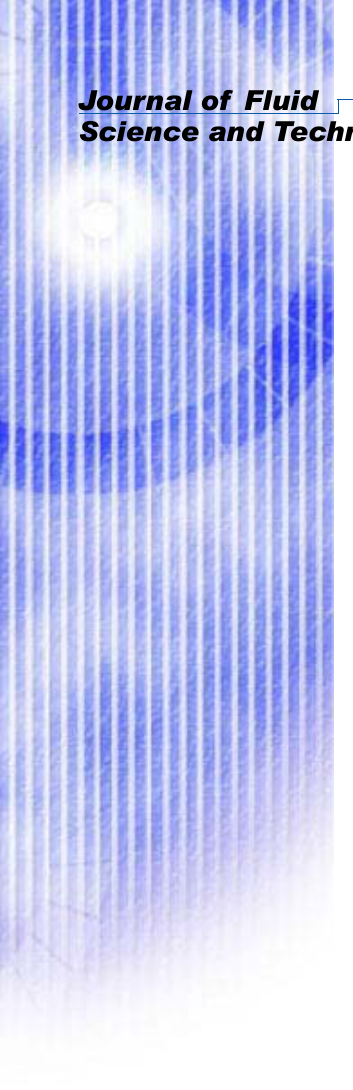
The dimensionless thermal fume height is H * = 0.5 determined by Expression (1) in dT the case of Q * / Fr = 0.9. There were no thermal fumes in the lower half of the tunnel in this situation. Furthermore, Expression (1) gave 15 MW as the heat release rate of the fire in the case of a full-scale tunnel (5-m height, 10-m width, 2-m/s emergency ventilation velocity). Expression (1) indicated that the evacuation environment under thermal fumes was sufficiently secured when the heat release rate of a full-scale fire was not greater than 15 MW. In the case of the thermal fume height downstream from the fire source in Fig. 10(b), the thermal fume height decreased exponentially with the increase of